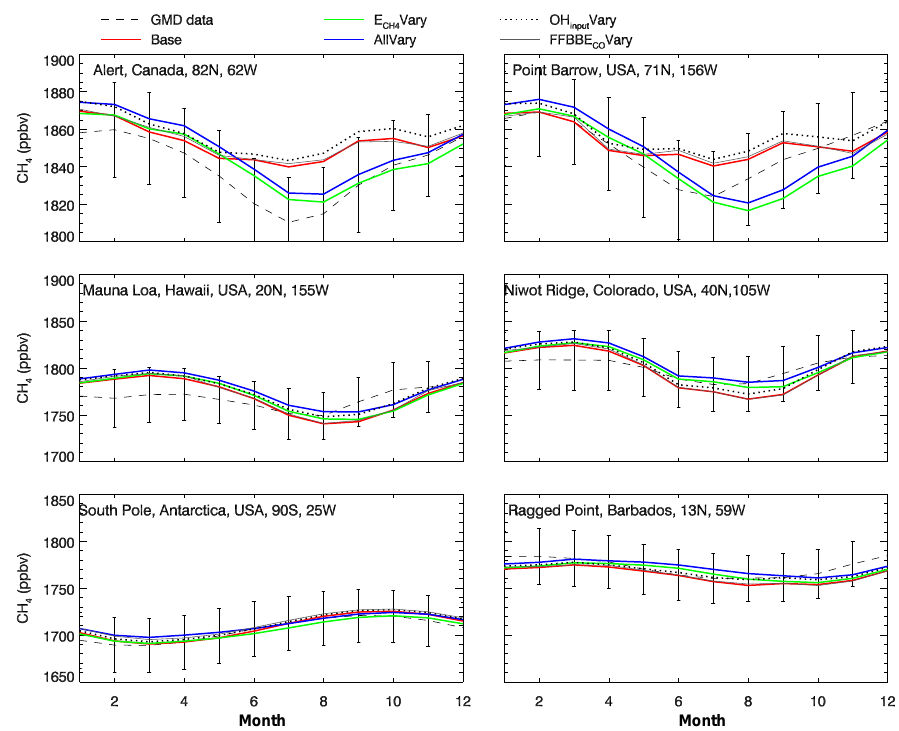
Figure 6. Monthly methane (ppbv) averaged over 1988–2007 for several scenarios and observations at six GMD stations. Vertical lines represent the standard deviation of the observed annual